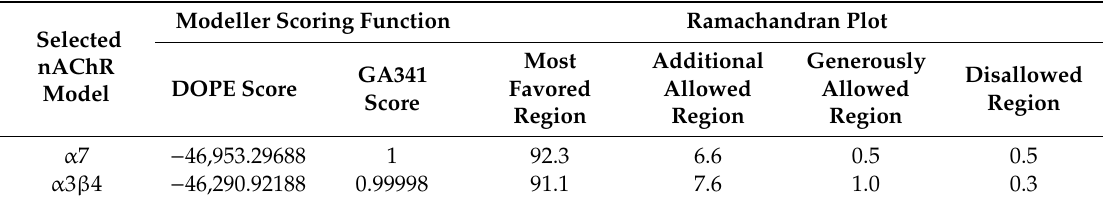
Table 2. Quality assessment of the selected α 7 and α 3 β 4 nAChR homology